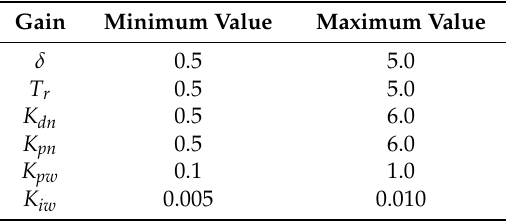
Table 2. Gains bounds based on the exhaustive search